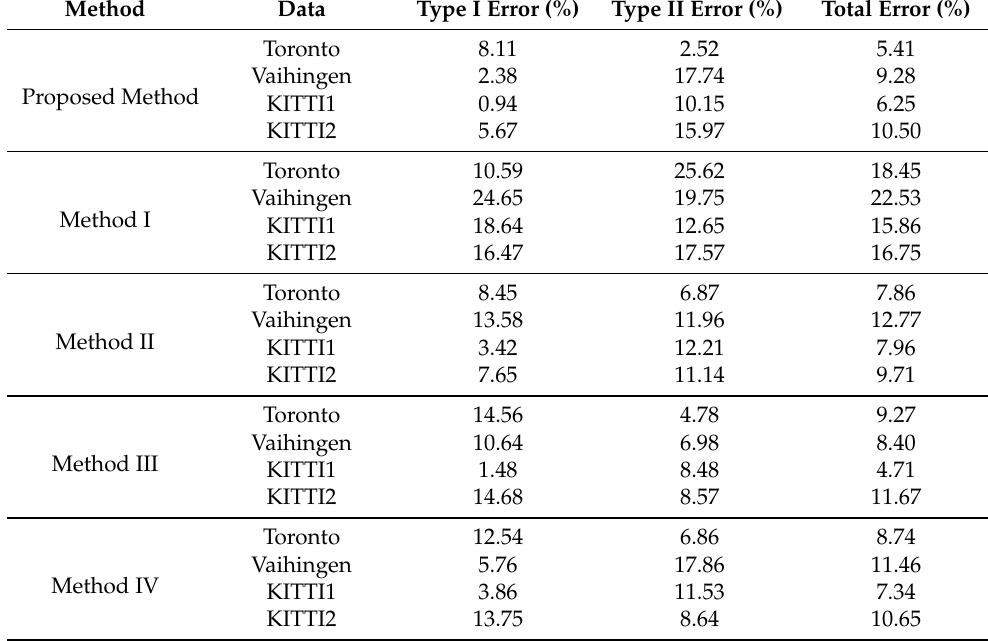
Table 1. Comparison of the errors of the proposed method and other